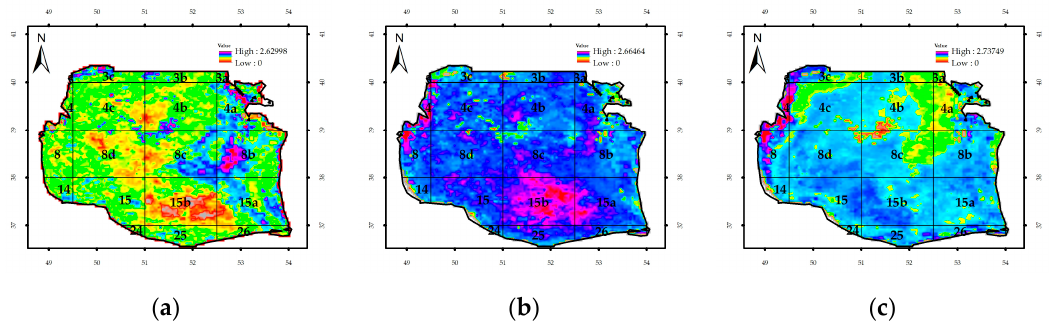
Figure A2. Durbin–Watson statistics before the prewhitening process for bio-optical parameters; ( a ) Chl-a, ( b ) attenuation coefficient, and ( c ) Rrs_555nm.